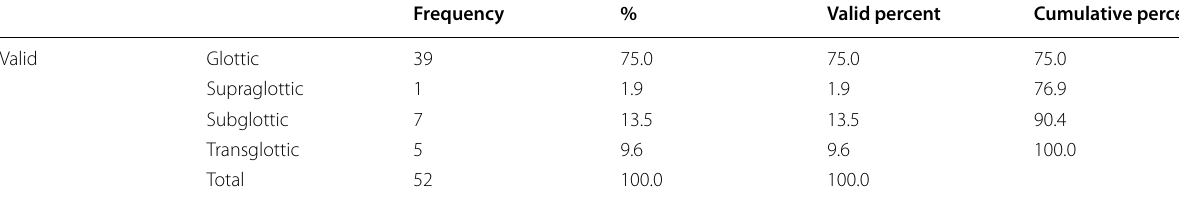
Table 1 Frequency distribution of the cases according to sites of the papilloma found intraoperatively